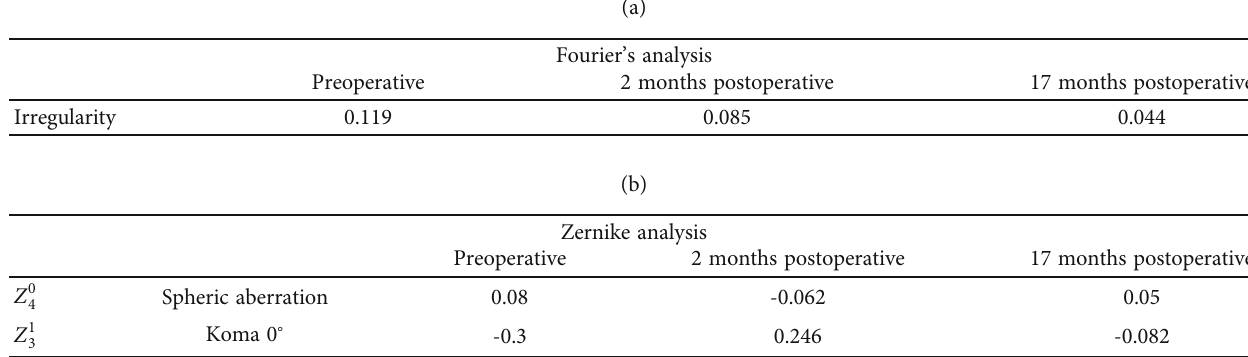
Table 1: Fourier ’ s analysis and Zernike analysis.